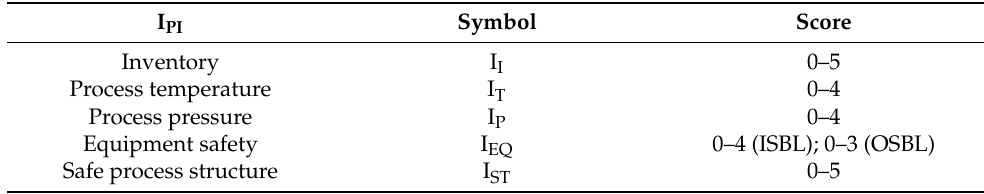
Table 2. The score for process safety